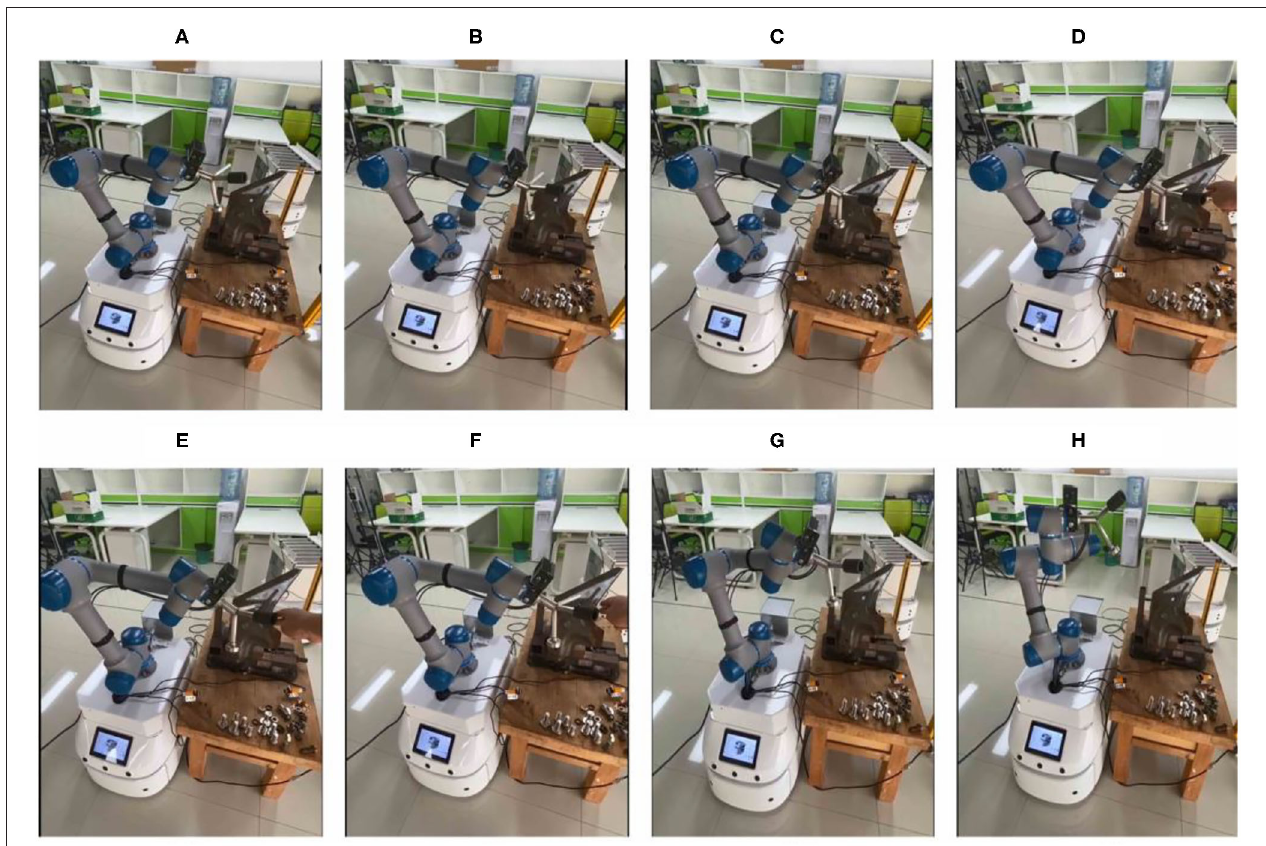
FIGURE 11 | Robot’s obstacle avoidance process. (A–C) Present Normal operation track. (D–H) Present Collision